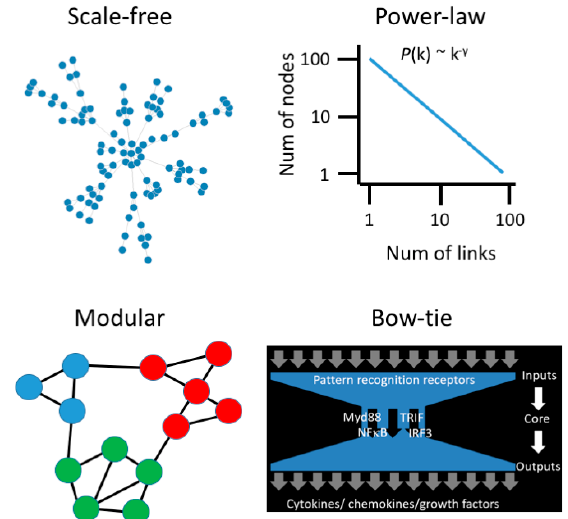
Figure 1. Emergent properties of biological networks. Scale-free networks follow a power-law degree distribution, meaning that most nodes have few links, and a few nodes have many links. Modules are subnets comprised of proteins that function in the same pathway. The innate immune system employs a bow-tie architecture to integrate diverse signals from a fluctuating environment.